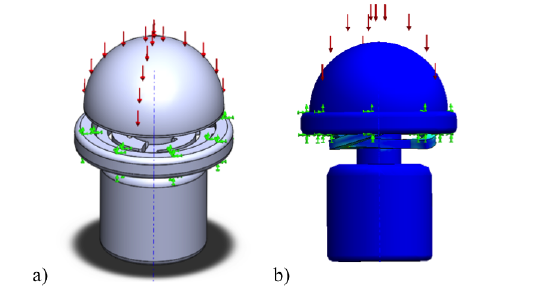
Figure 6. FE simulation of loading of ortho-planar spring: ( a ) Three-dimensional computer model with fixture points shown in orange; ( b ) simulation of the compressed